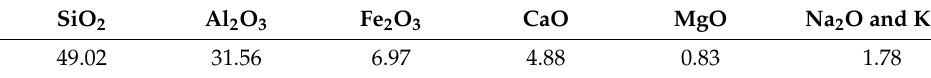
Table 3. Chemical composition of fly ash (%).